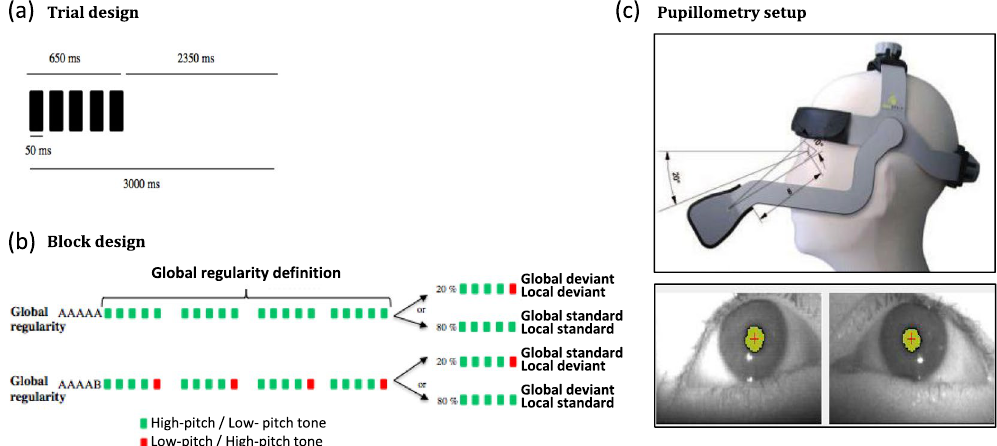
Figure 1. Auditory paradigm and pupillometry setup ( a ) On each trial 5 sounds were presented. ( b ) Each experimental block started with series of sounds defining the global regularity, before delivering global